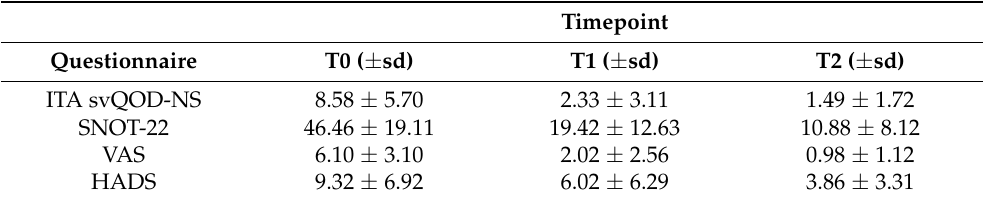
Table 2. Overall scores from each questionnaire among cases pre-operatively (T0), one month (T1) and nine months after surgery (T2). sd = standard deviation.